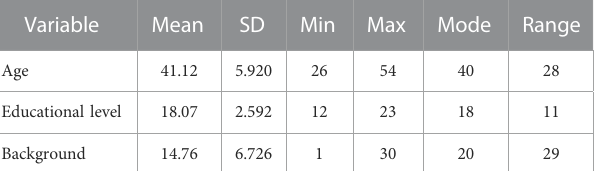
TABLE 3 Demographic characteristics of respondents in the studied organizations.